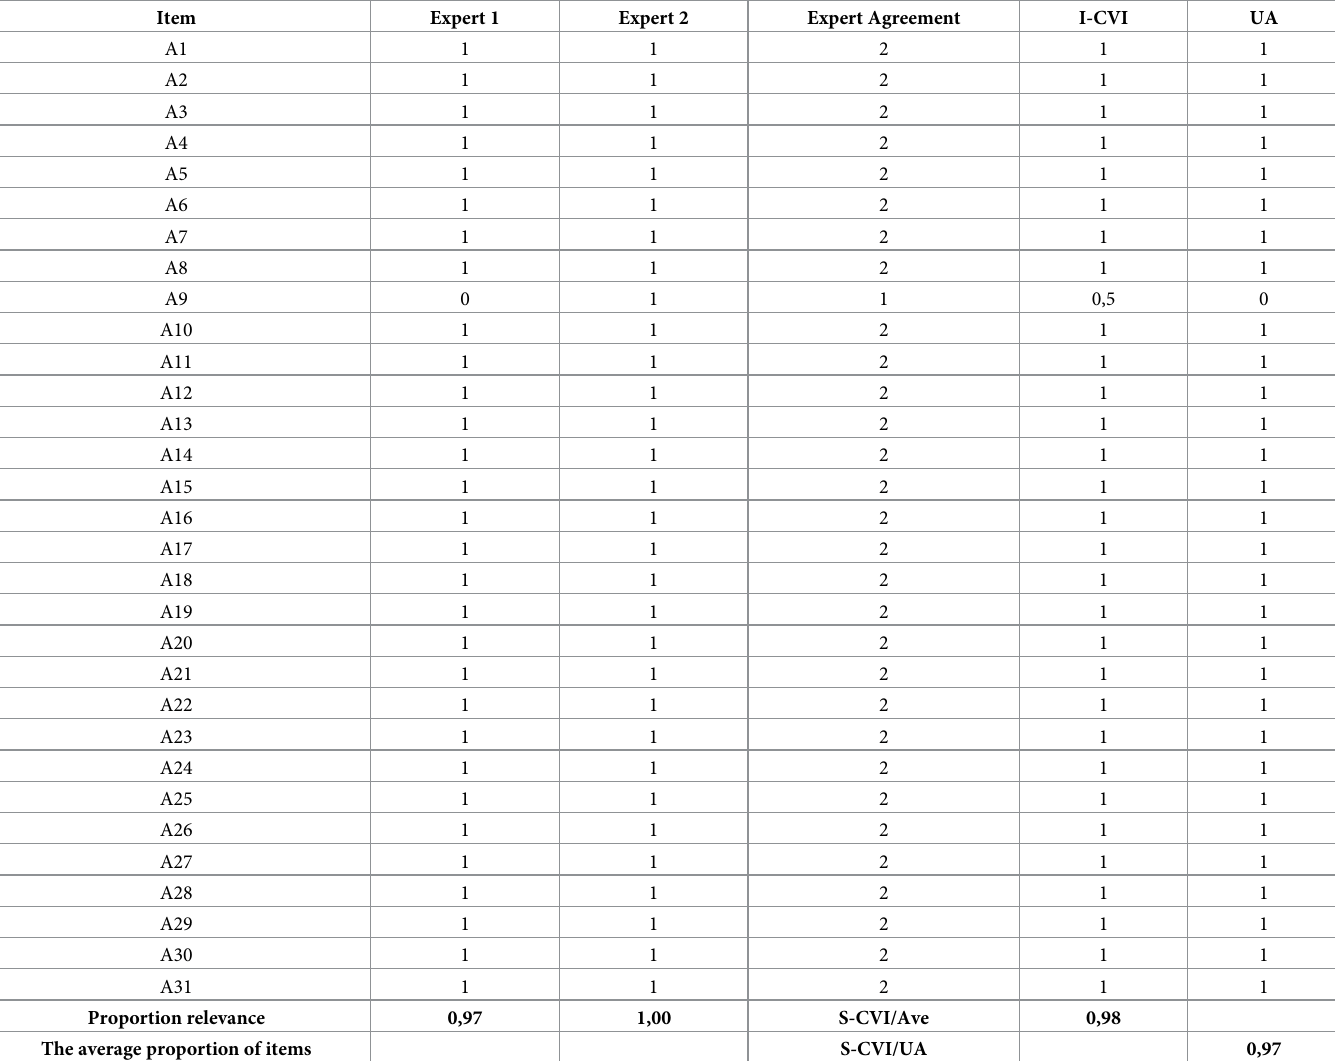
Table 3. I-CVI and S-CVI of scale of happiness at work.